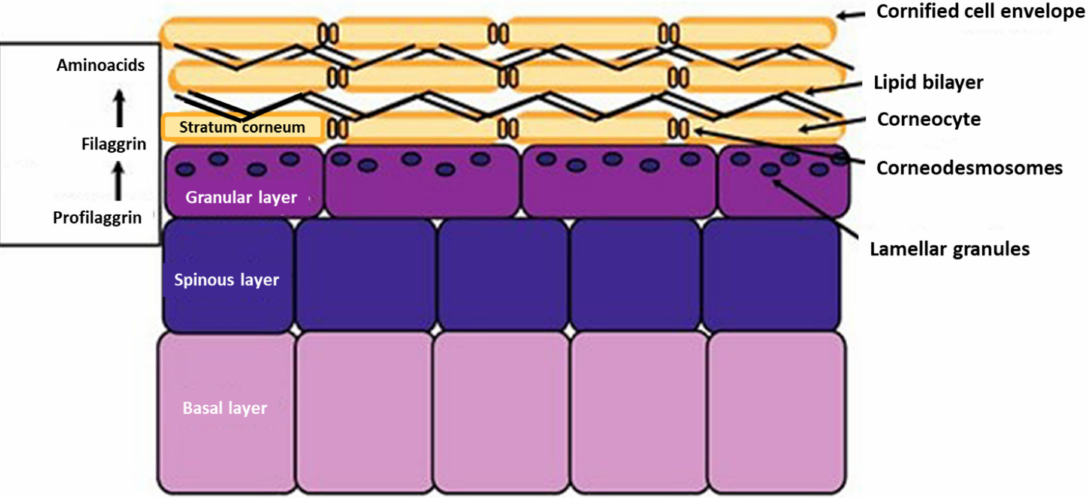
Figure 2. Skin turnover and NMF generation (i.e., amino acids and other compounds) through the corneocytes